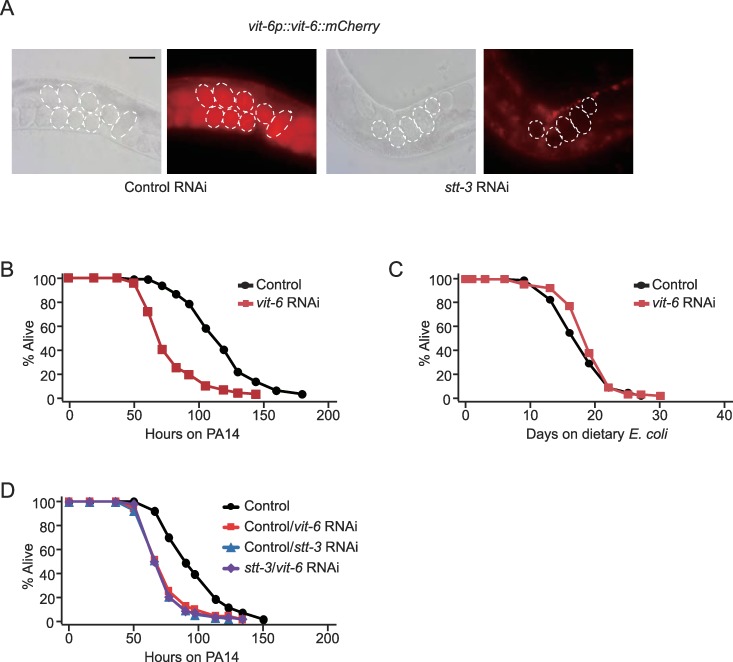
PA14 infection promotes OST-dependent N-glycosylation of VIT-6 that is responsible for ER homeostasis.(A) Fluorescence images of vit-6::mCherry transgenic animals treated with control or stt-3 RNAi. Dashed lines indicate embryos in the day 2 adult worms. Scale bar indicates 100 μm. (B-C) RNAi targeting vit-6 reduced the survival of wild-type (N2) worms on PA14 (B) without decreasing lifespan on E. coli diets (C). (D) RNAi targeting vit-6 did not affect the survival of worms treated with stt-3 RNAi. See S3 Table for additional repeats and statistical analysis for survival assay results in this figure.